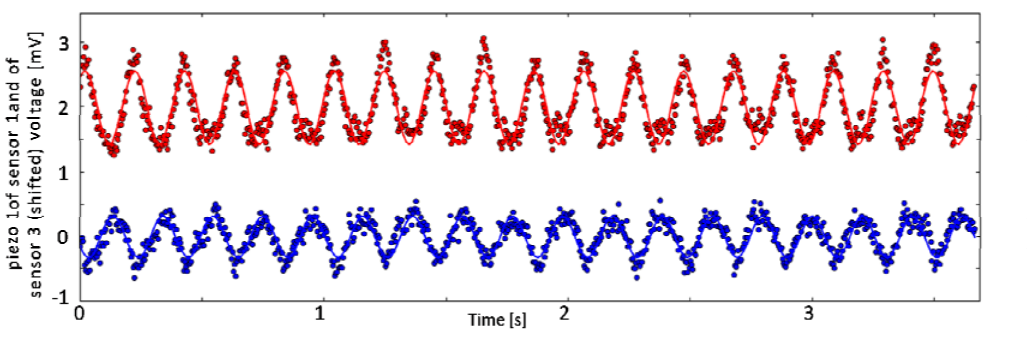
Figure 6. Result of the least squares fitting procedure considering piezoresistor 1 of MEMS sensor 1 (blue line) and piezoresistor 1 of MEMS sensor 2 (red line, shifted for easing the graphical representation) with a maximum width time window. The plot refers to data series 20, where a grating of 3.1 mm spatial periodicity was applied with translational speed of 15 mm/s, according to Tables 2 and 3.